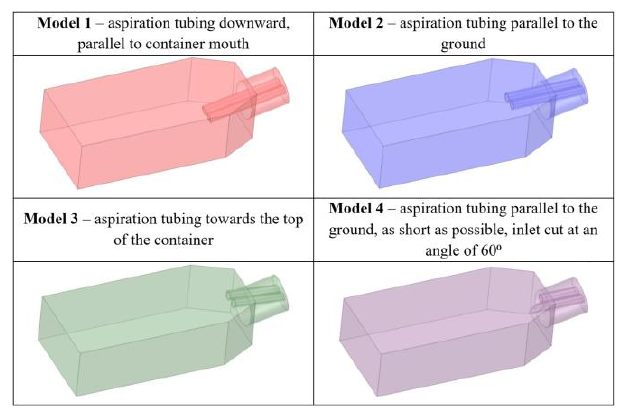
Fig. 4. Different solutions of the shape of aspiration tubing For the purpose of the simulation, the sampler construc- tion was simplified. The 3D spatial model was discretised. A tetrahedral mesh with an element size of 0.001 m was applied. In order to compact the mesh locally, a wall layer was applied to the lower wall of the sampler.